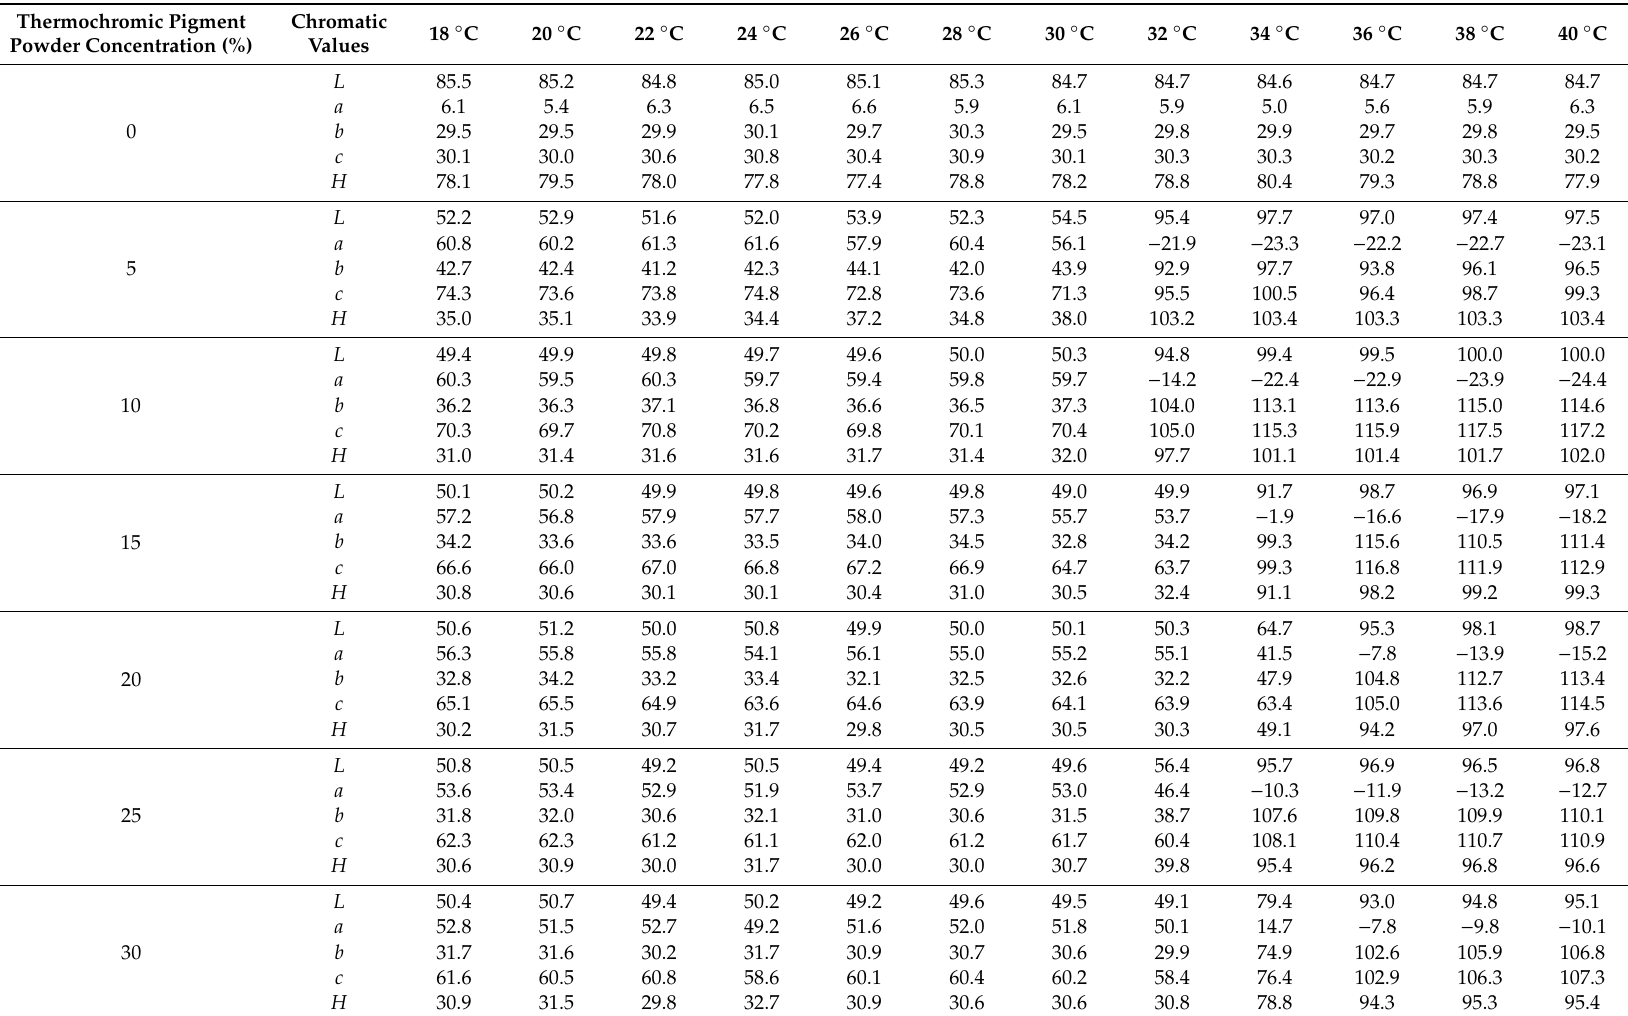
Table 3. Influence of thermochromic pigment powder on the color variation of the waterborne primer film. Thermochromic Pigment Powder Concentration